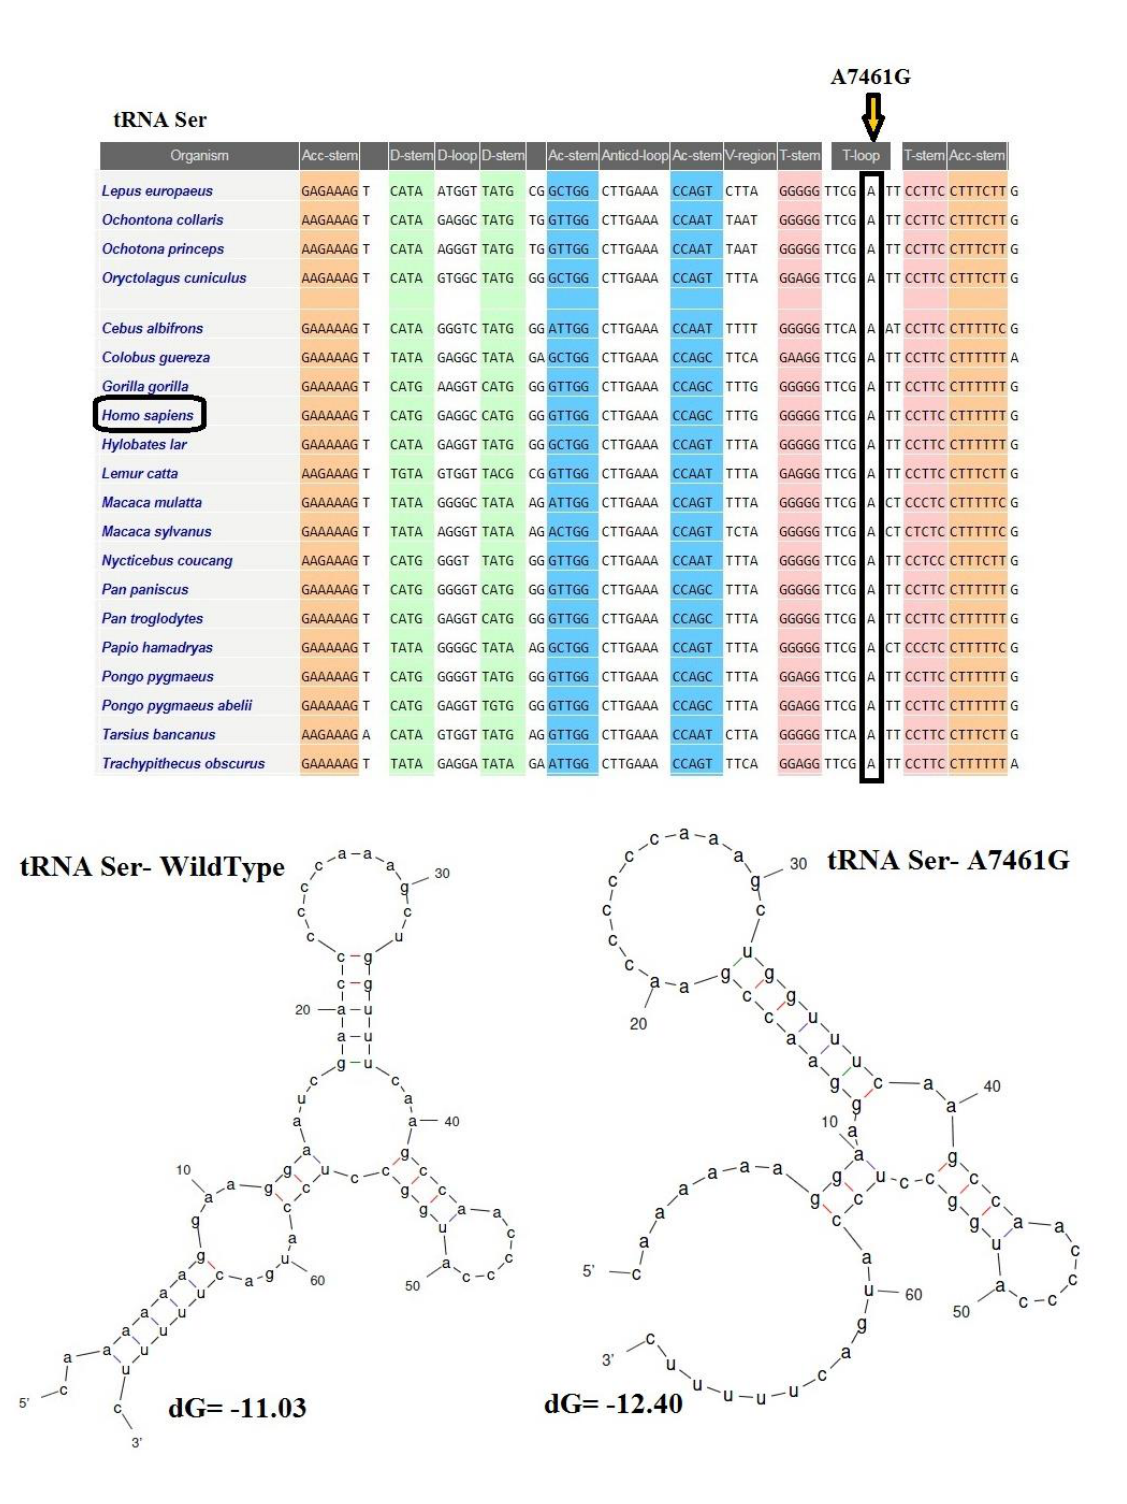
Figure 4: Sequence alignment of tRNA Ser reveals a high-degree of conservation of A7461 nucleotide across species. A representation of the structural and folding effect of the A7461G mutation in tRNA Ser was predicted using the Mfold program is also represented below the sequence alignment. The free energy change between the mutant and wild-type states was